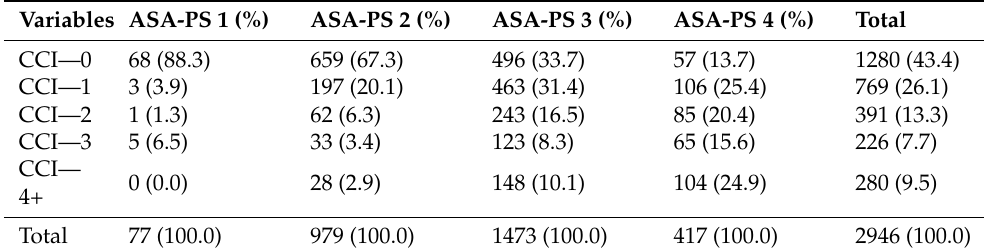
Table 2. Frequency distributions of the ASA-PS grade and the Charlson Comorbidity Index using the training